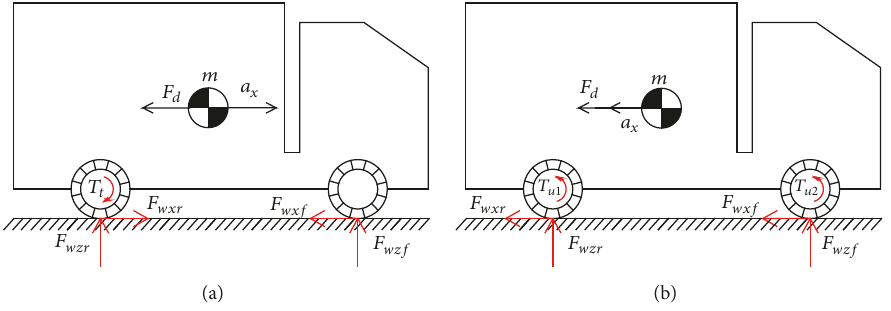
Figure 2: Forced status of vehicle in longitudinal direction: (a) acceleration and (b)